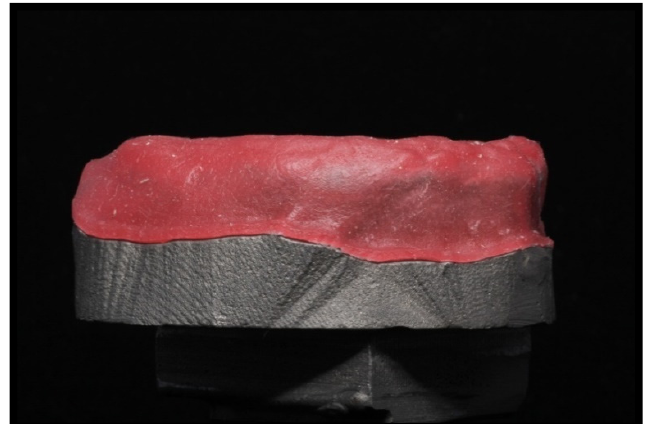
Figure 3. Titanium reduced gingival, high-alveolar-ridge model for mechanical tests.